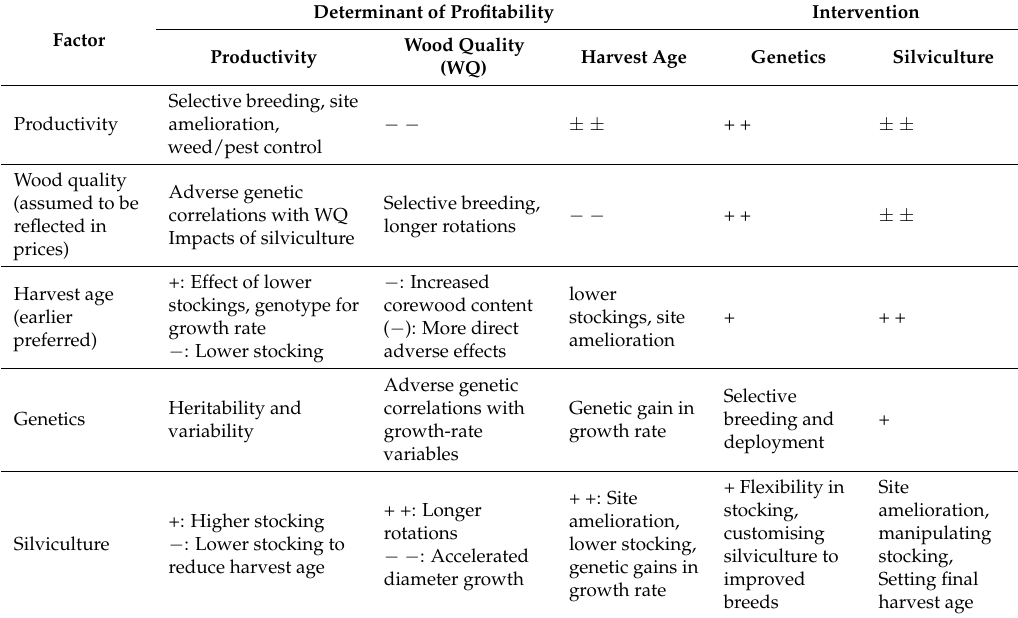
Table 1. Interplays between determinants of profitability and genetics and silviculture, in radiata pine, with main qualitative relationships indicated above diagonal, and main mechanisms for effects below diagonal, and directly beneficial measures on diagonal. Determinant of Profitability Intervention Wood Quality